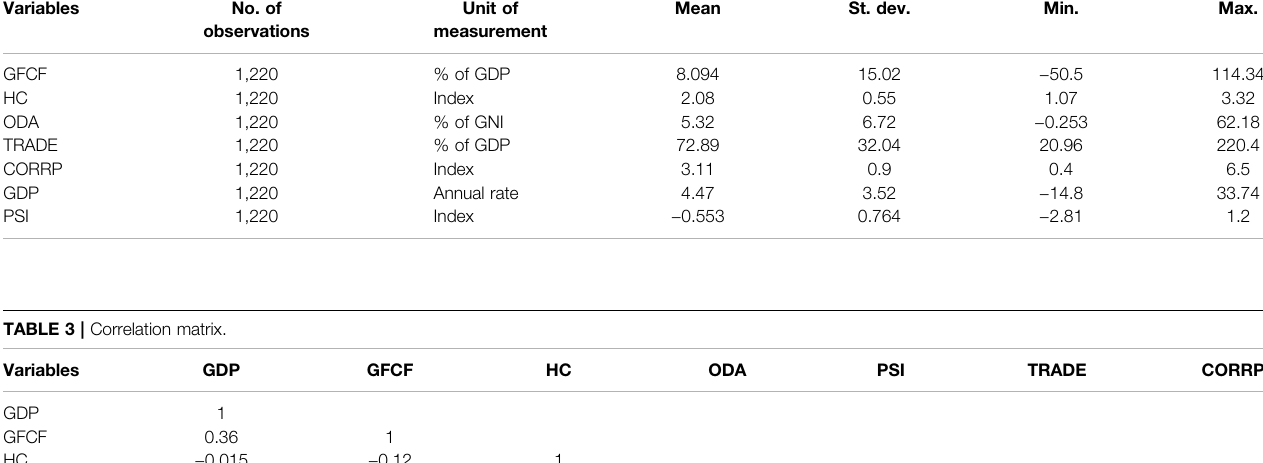
TABLE 2 | Summary statistics of data for developing economies. Variables